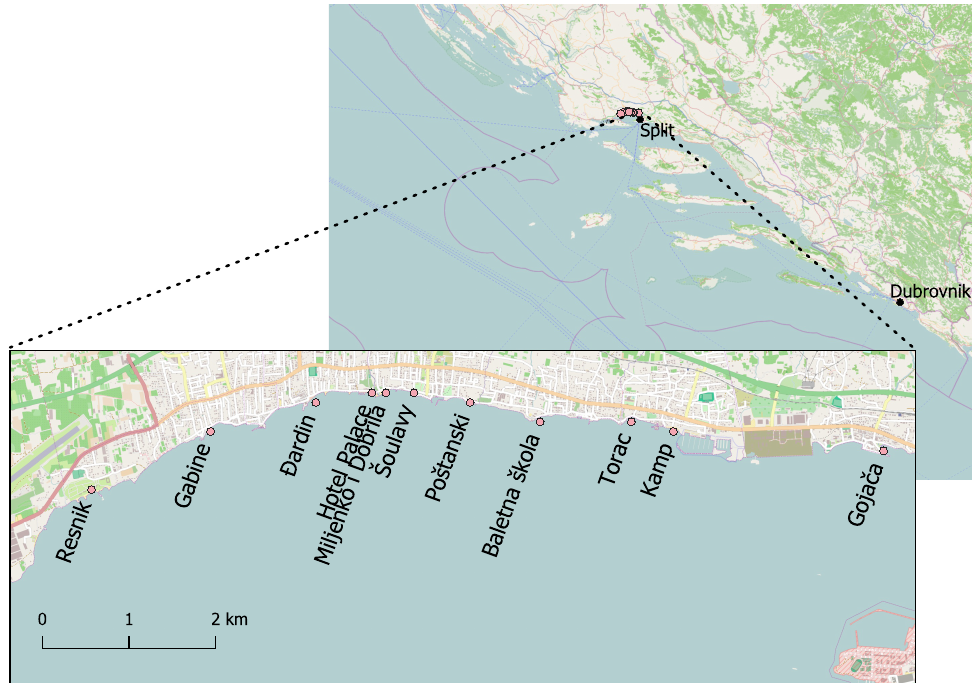
Figure 1. Map of Kaštela Bay and bathing sites where samples were